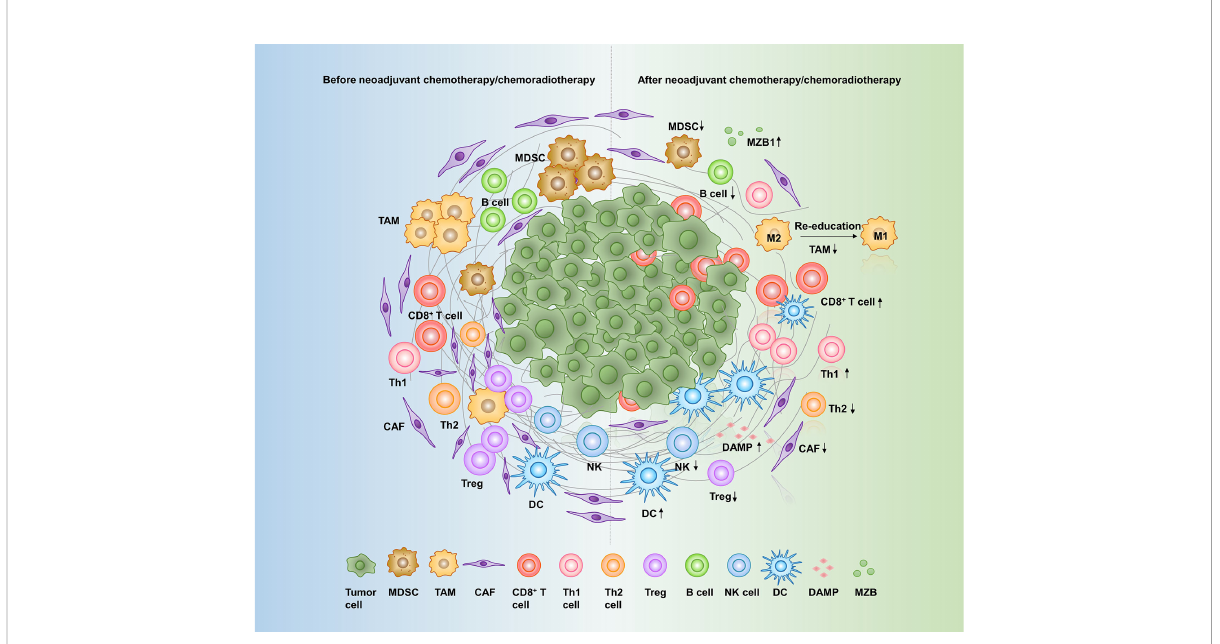
FIGURE 1 Effects of neoadjuvant therapy on the pancreatic cancer microenvironment. A variety of cells and molecules in the pancreatic cancer microenvironment are altered in response to neoadjuvant therapy: CD8 + T cells, Th1 cells, DCs, DAMPs, and MZB1 are increased, while CAFs, Th2 cells, Tregs, MDSCs, TAMs, NK cells, and B cells are decreased. MDSC, myeloid-derived suppressor cell; TAM, tumor-associated macrophage; CAF, cancer-associated fi broblast; Th cell, T helper cell; Treg, regulatory T cell; NK cell, natural killer cell; DC, dendritic cell; DAMPs, damage-associated molecular patterns; MZB1, Marginal zone B- and B1-cell-speci fi c